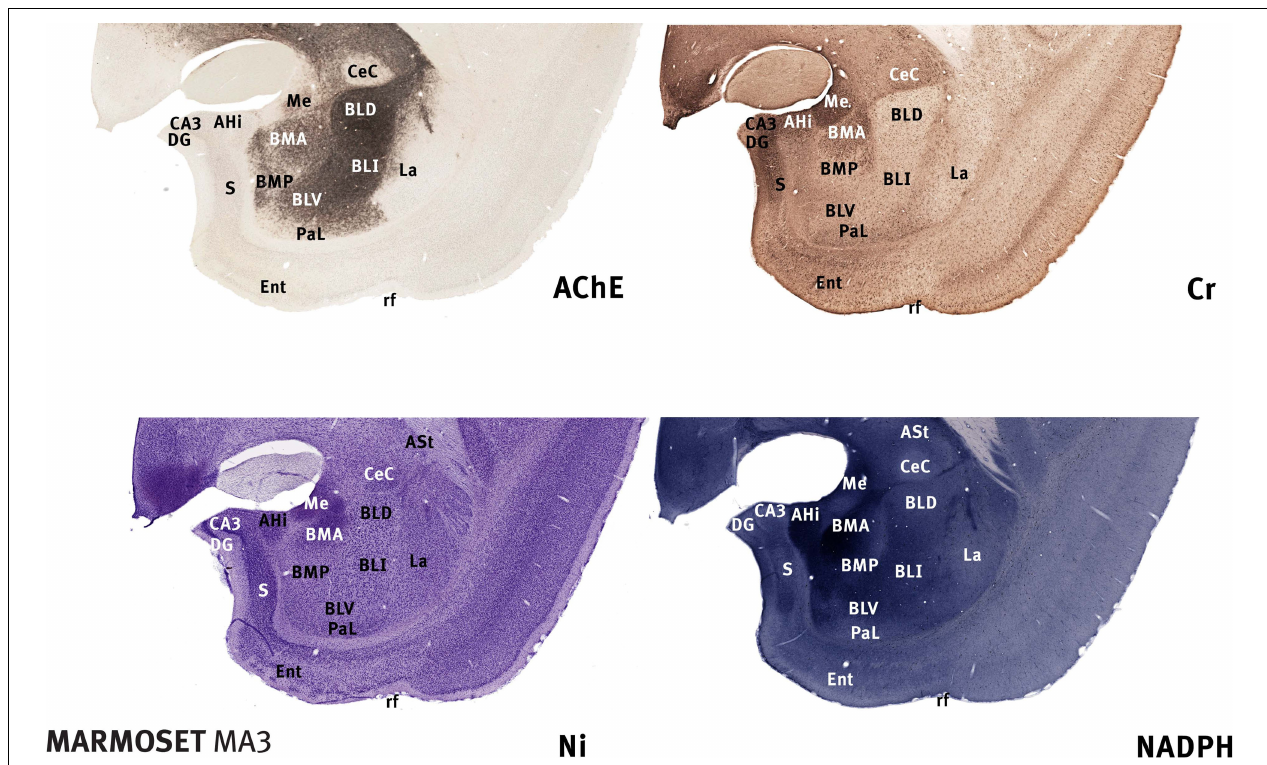
defi ned by intense AChE staining. The basomedial nucleus (BMA and BMP) and the amydalohippocampal area (AHi) are intensely stained with NADPH. The medial nucleus (Me) and the dorsal part of the basomedial nucleus (BMA) are notably stained with Cr. Scale – the fi eld of view in each case is 10-mm